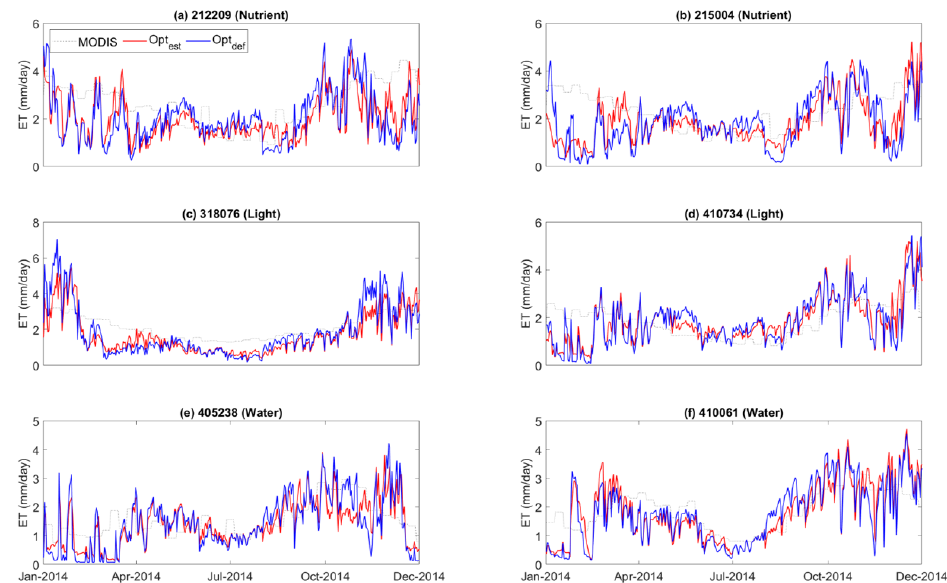
Figure 4. 1-year time series of daily ET derived from MODIS (black dotted-line) and simulated by Opt def (blue continuous line) and Opt est (red continuous line) respectively for six selected catchments: